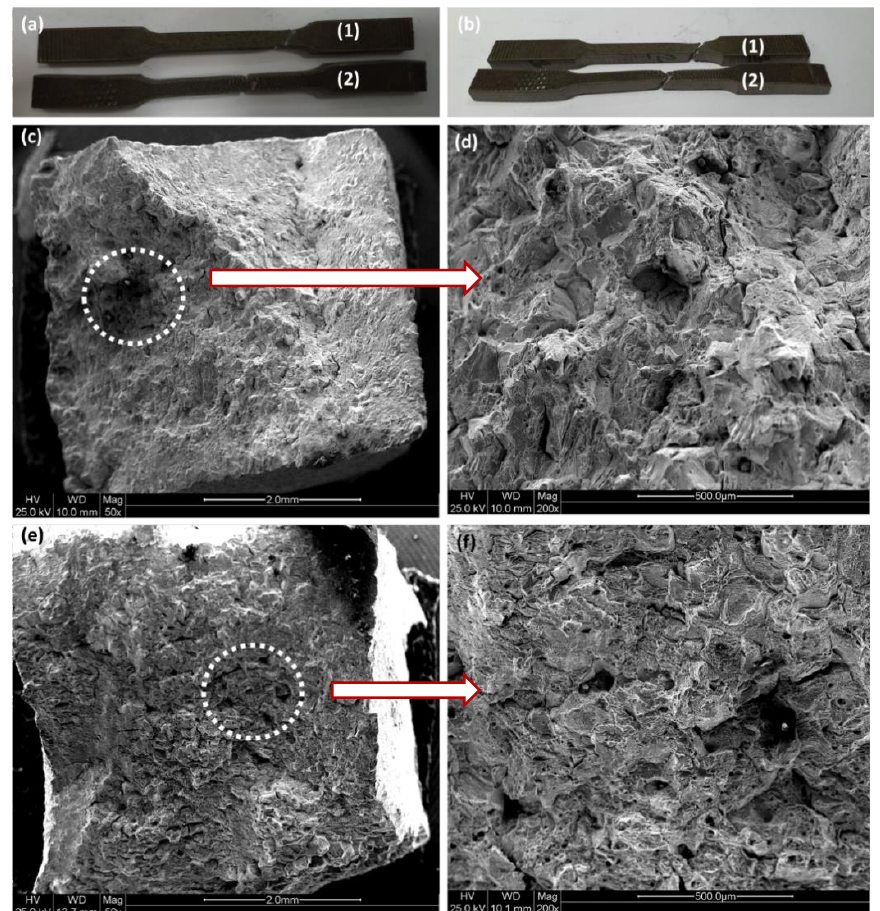
Figure 9 . Fracture surface morphology: ( a,b ) Macroscopic images for specimens 1 and 2, respectively; Figure 9. Fracture surface morphology: ( a , b ) Macroscopic images for specimens 1 and 2, respectively; ( c,d ) SEM images for specimen 1; ( e,f ) SEM images for specimen 2. ( c , d ) SEM images for specimen 1; ( e , f ) SEM images for specimen 2. Specimens 1a,b and 2a,b represent the specimens far and near from the failure region, respectively. From the macroscopic image (Figure 9a,b), it is clear that the specimen near